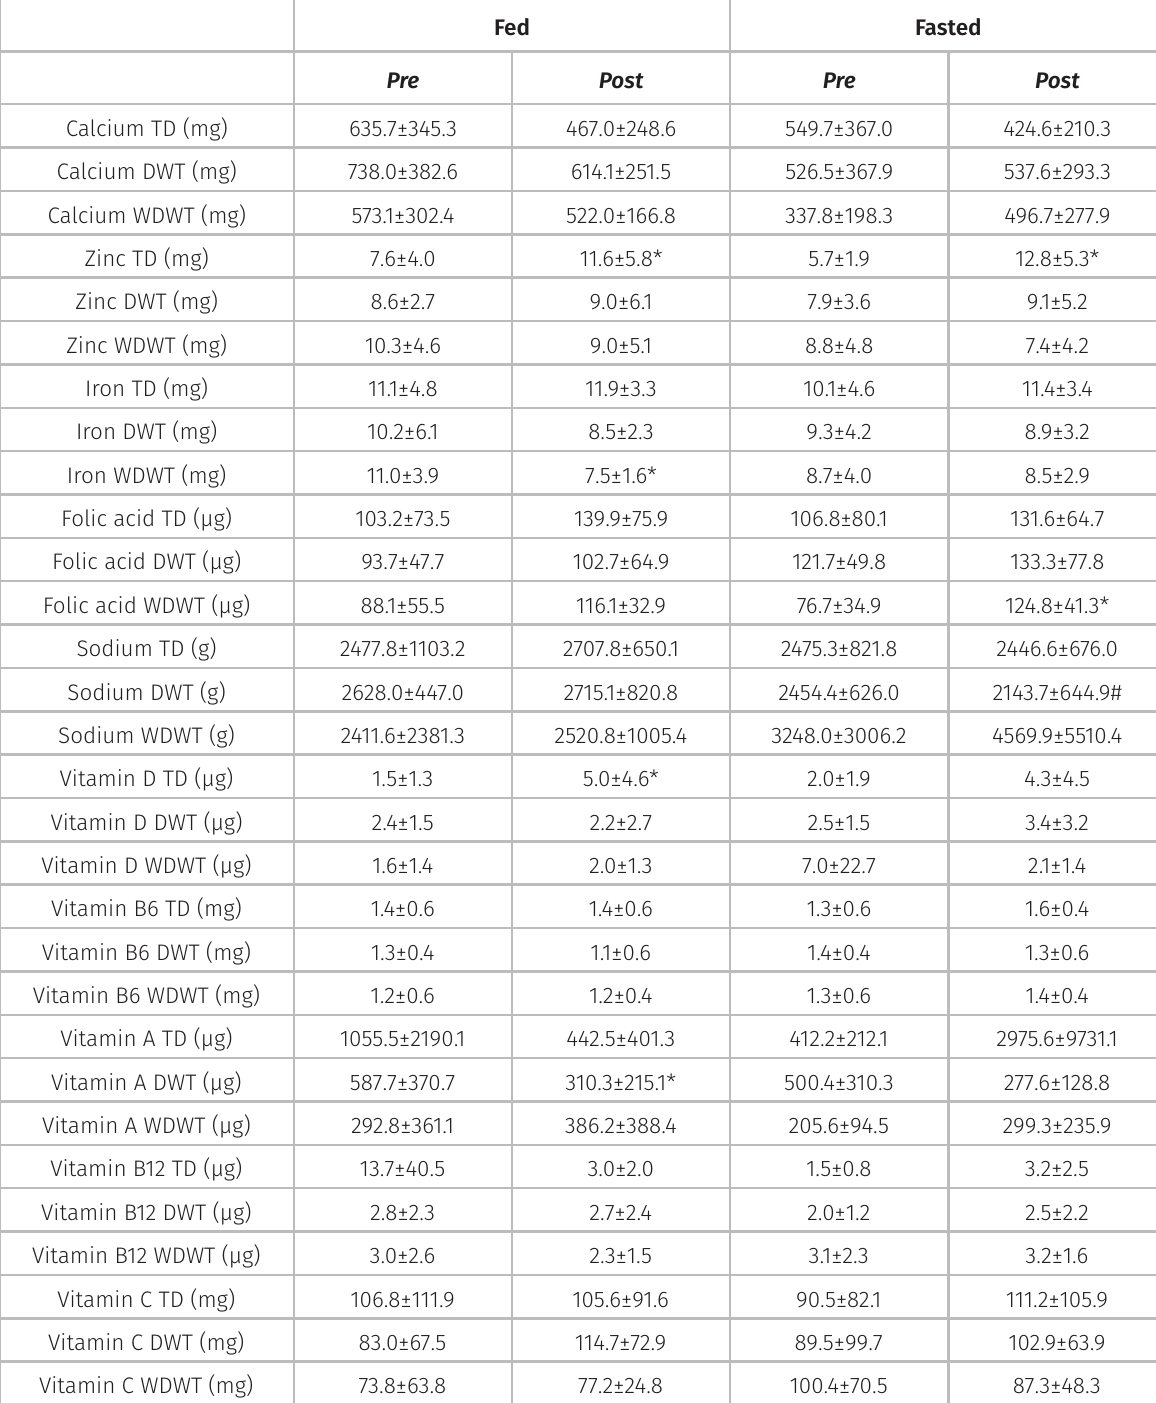
Table III. Micronutrient intake of participants between the fed and fasted conditions before and after the multicomponent training intervention on different days of the week. Fed